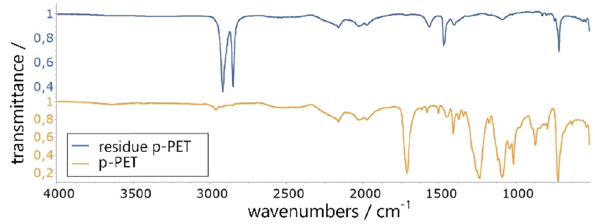
Figure 11: FT - IR - spectra of the residue of the depolymerized p - PET starting